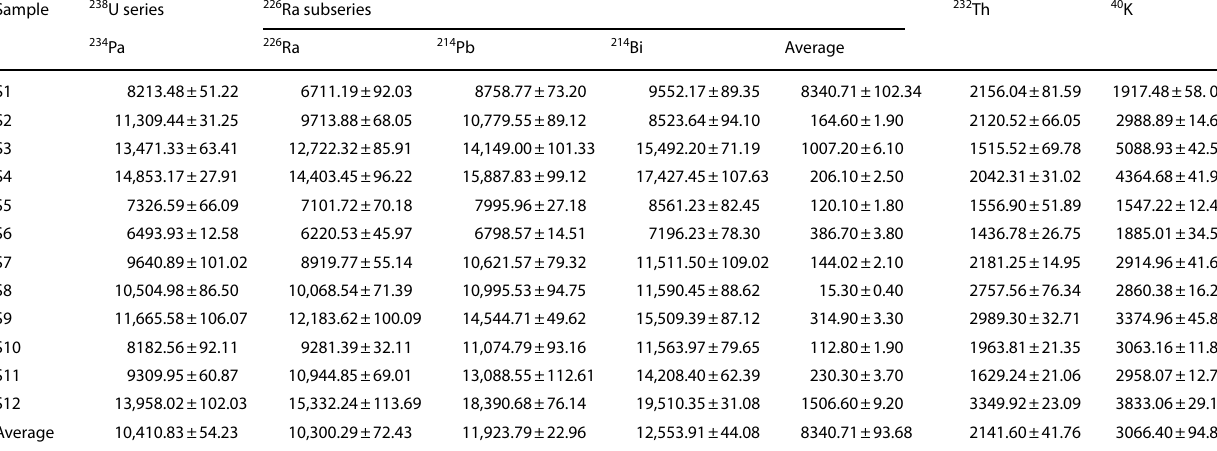
Table 2 Distribution of activity concentrations for different radionuclides in (Bq kg −1 )